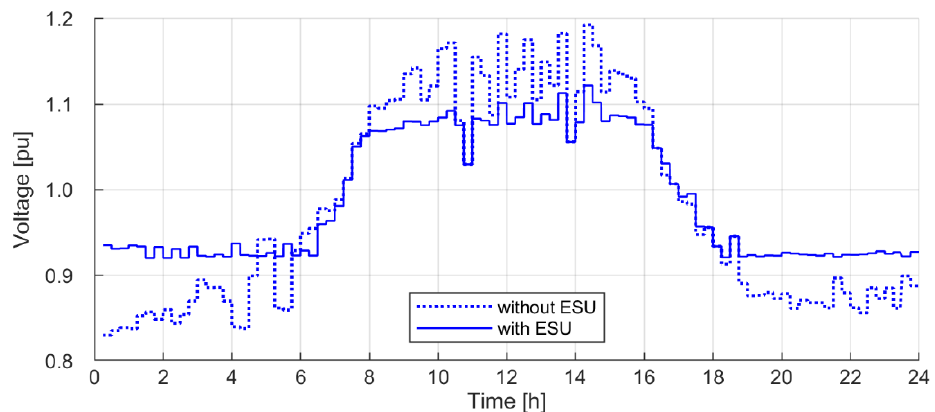
Figure 17. Daily voltage variations in node 526 (profile B).